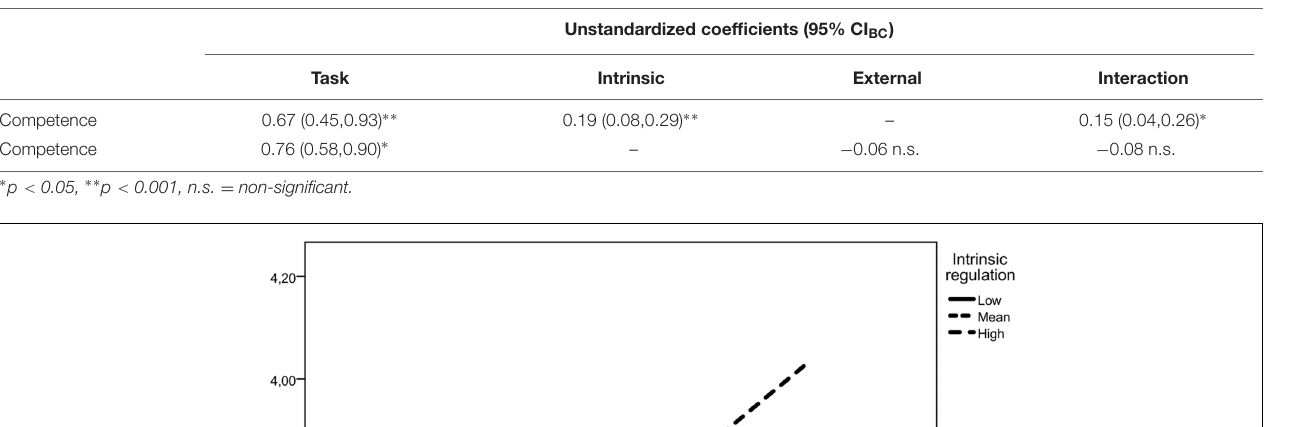
95% CI BC :0.20,0.56). This was supported by the loop plot results, showing that the conditional indirect relationship was significant at all levels of intrinsic regulation, as such the regions of significance was the entire samples range of